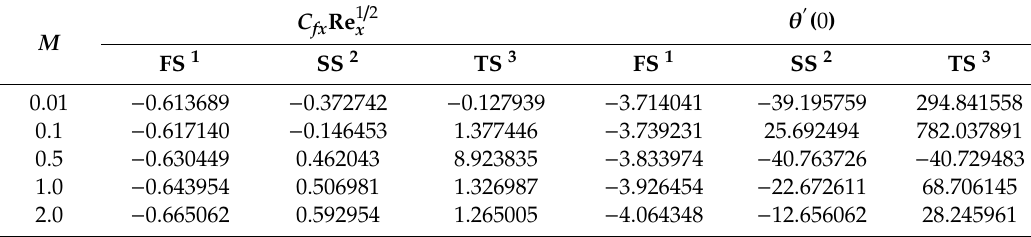
1 FS = First solution. 2 SS = Second solution. 3 TS = Third